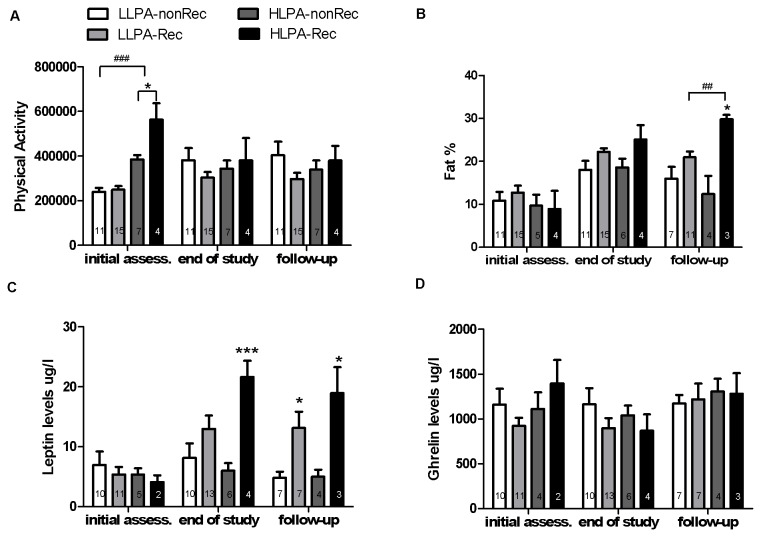
Differences between recovered and non-recovered LLPA and HLPA patients.Daily physical activity scores (A), fat% (B), leptin serum levels (C), and ghrelin serum levels (D) plotted for recovered and non-recovered LLPA and HLPA groups at 3 time points (initial assess. = initial assessment). Data are expressed as mean ± SEM; Two-way ANOVA, Student’s t-test as a post hoc test: * P<.05, *** P<.001 between the recovered (Rec) and non-recovered (nonRec) patients in the same group (LLPA or HLPA) and at the same time point; ## P<.01, ### P<.001 between the LLPA and the HLPA groups at the same time point. Numbers within bars indicate sample size per group.